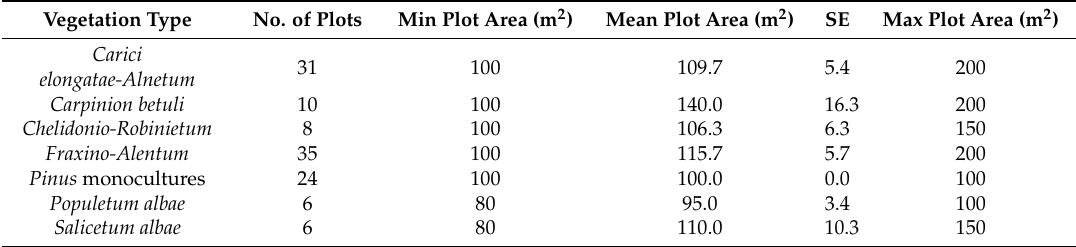
Table 2. Number and sizes of study plots representing each vegetation